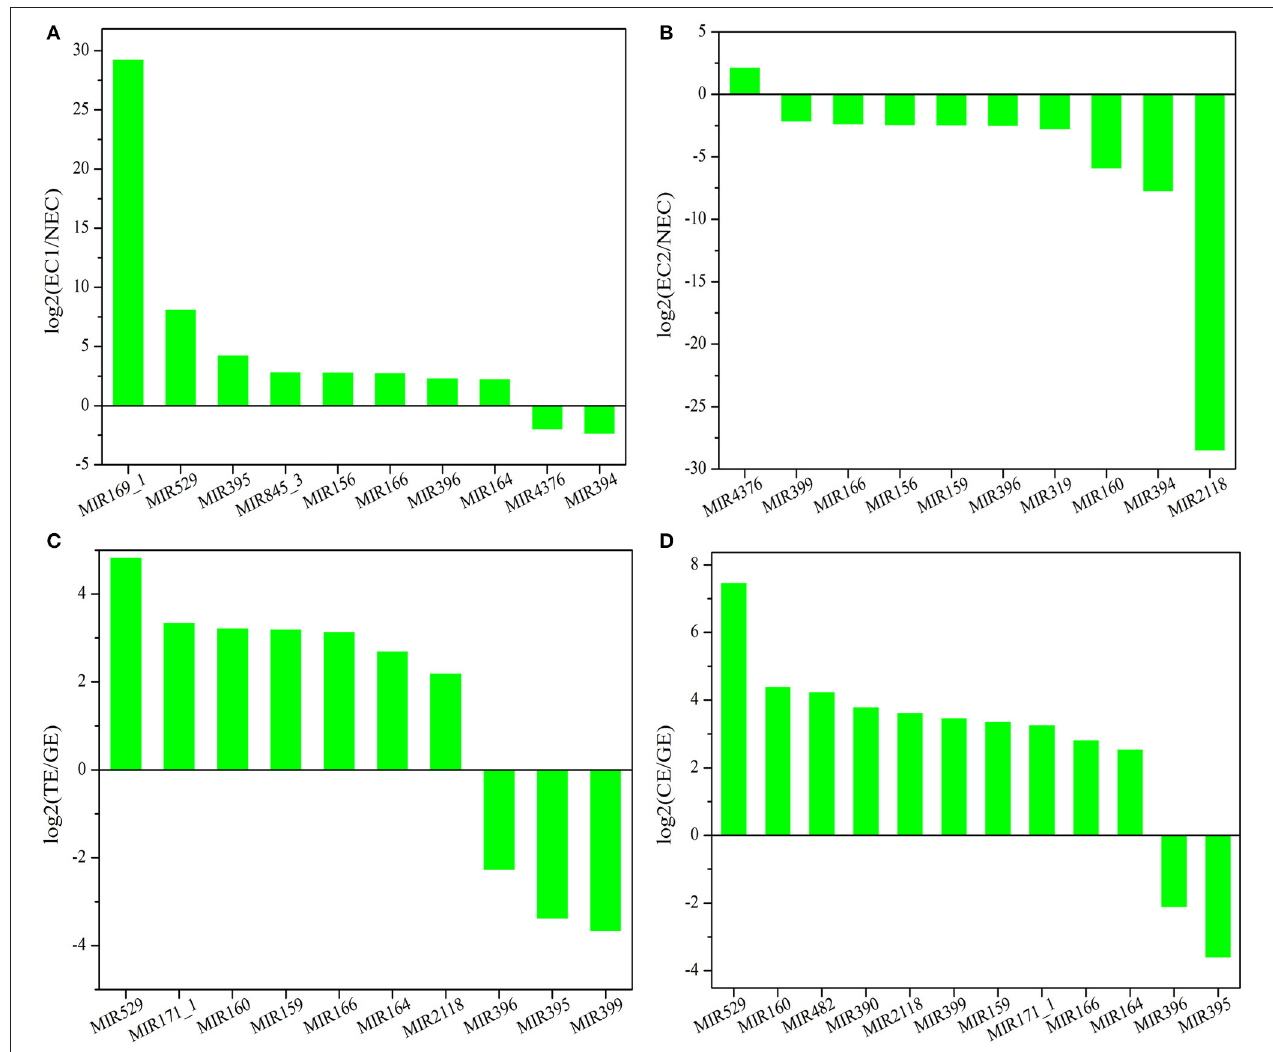
FIGURE 5 | Differentially expressed known miRNA families in Lilium pumilum DC. Fisch. (A) comparison of differentially expressed known miRNA families between NEC and EC1; (B) comparison of differentially expressed known miRNA families between NEC and EC2; (C) comparison of differentially expressed known miRNA families between GE and TE; (D) comparison of differentially expressed known miRNA families between GE and CE.